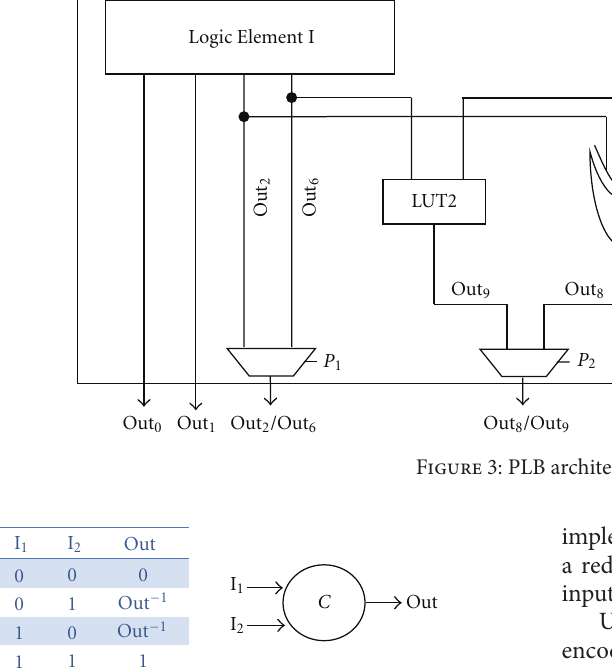
Figure 4: Muller 𝐶